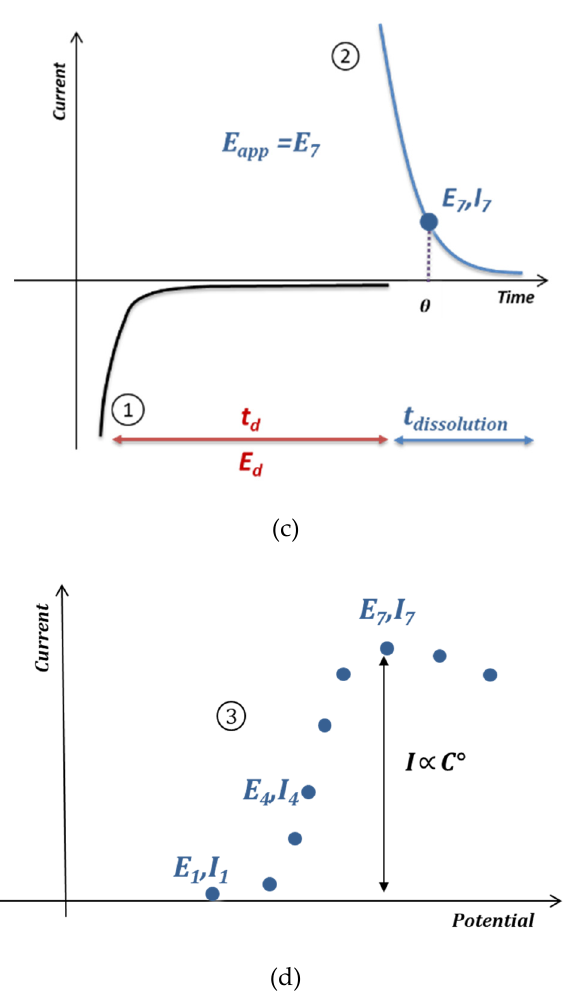
Figure 5. Principle of anodic stripping voltammetry on an electrode array; Electrodeposition step (1) and oxidation of species accumulated on the electrode (2) by chronoamperometry with a different potential for each working electrode number 1 (a), 4 (b), 7 (c) and sampling of the current for a defined time θ , leading to the I-E curve 3 (d).